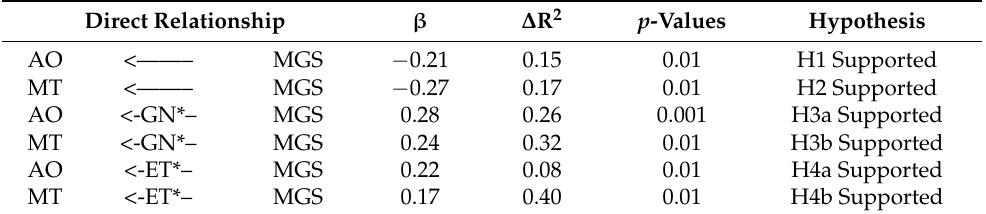
Table 4. Standardized Regression: MGS direct and moderated relations with AO and MT.